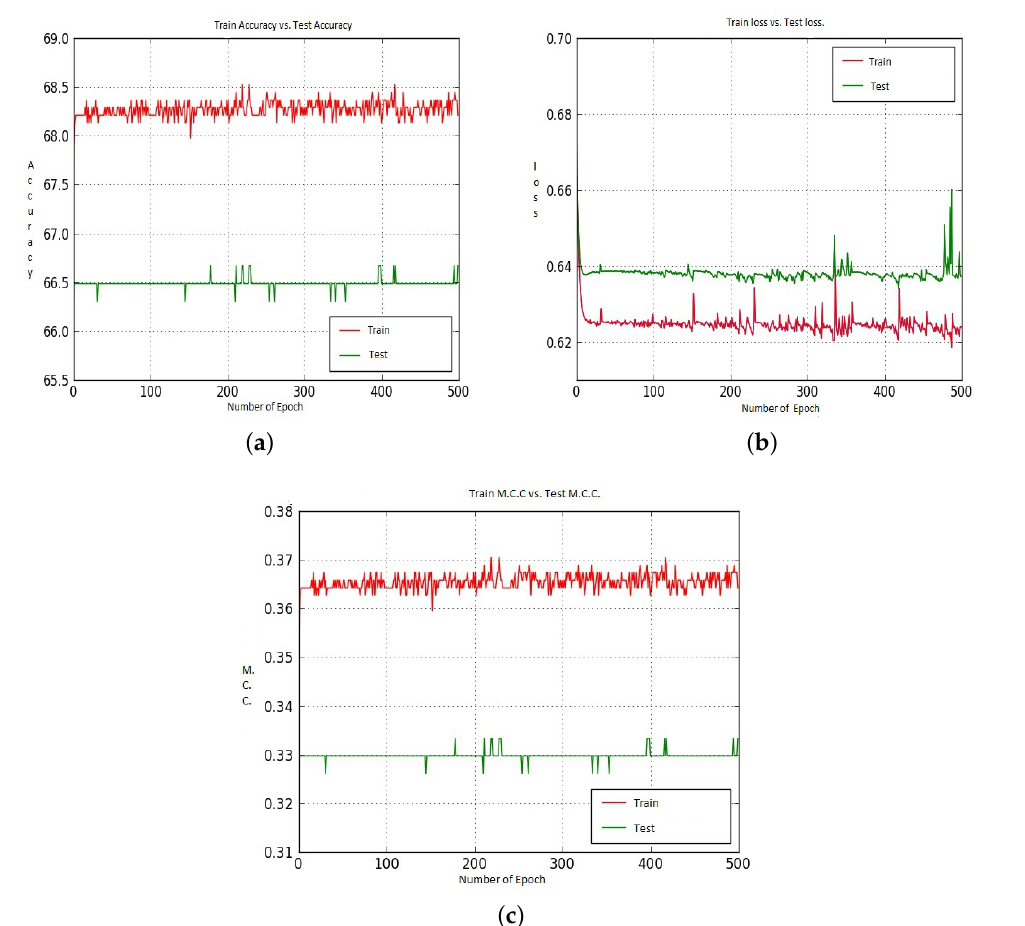
Figure 17. ( a – c ) represent the Train and Test Accuracy, Loss and M.C.C. values when we have utilized Model-2, CNN-CH case on the 400 × dataset.